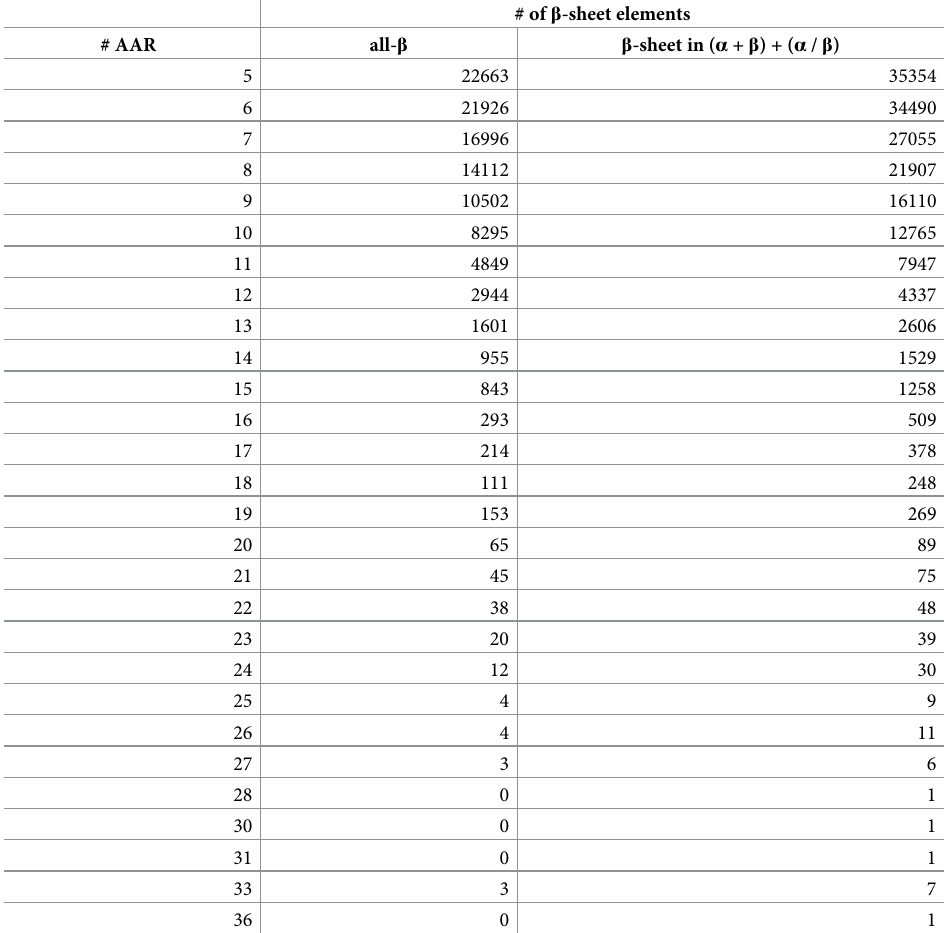
Table 2. Number of β -sheet elements (ordered by their length) for all- β and β in ( α + β ) + ( α / β )